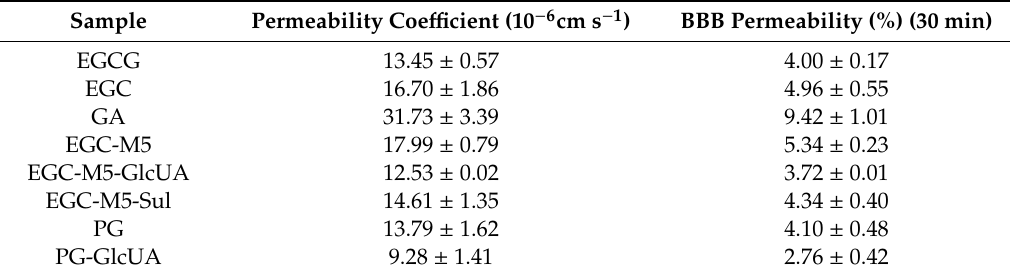
Table 2. BBB permeability of EGCG